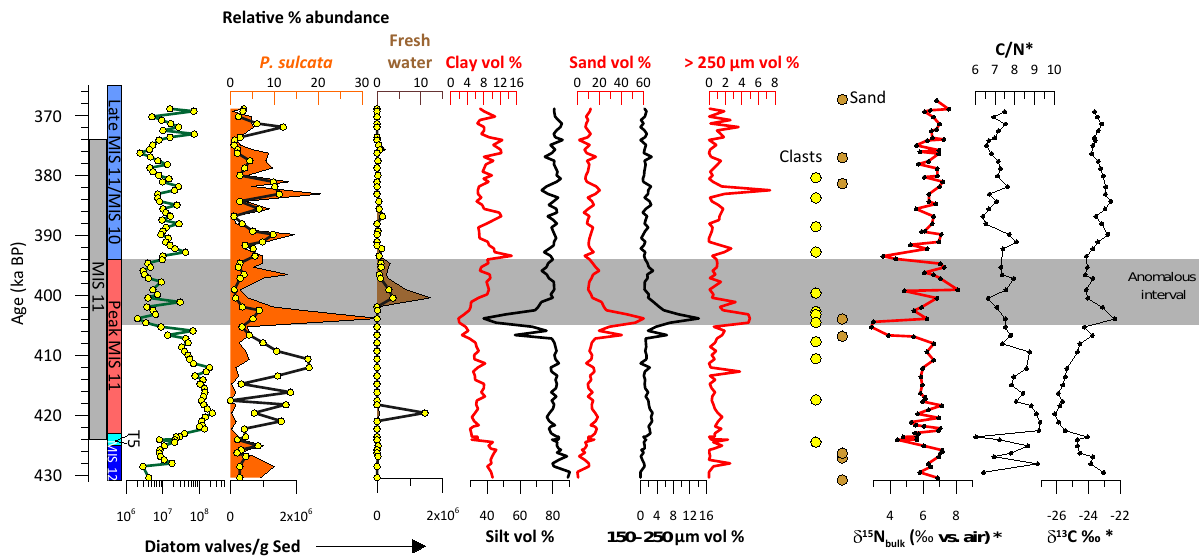
Figure 10. Proxy indicators of shelf to basin transport. The grey vertical bar depicts the duration of MIS 11; colored vertical bars refer to the zones mentioned in the text. Total diatom absolute abundances are plotted next to absolute (line plots) and relative percent abundance of P. sulcata (orange area plot) and freshwater species (brown area plot). High-resolution grain size includes % clay (red), silt (black), sand (red), 150–250µm (black) and greater than 250µm (red). Yellow circles indicate isolated clasts (IRD), maroon circles indicate sand layers for all holes at U1345. Geochemical data are plotted as δ 15 N (red), C / N (black), and δ 13 C (black). The grey bar spans 405–394ka, the so-called “anomalous